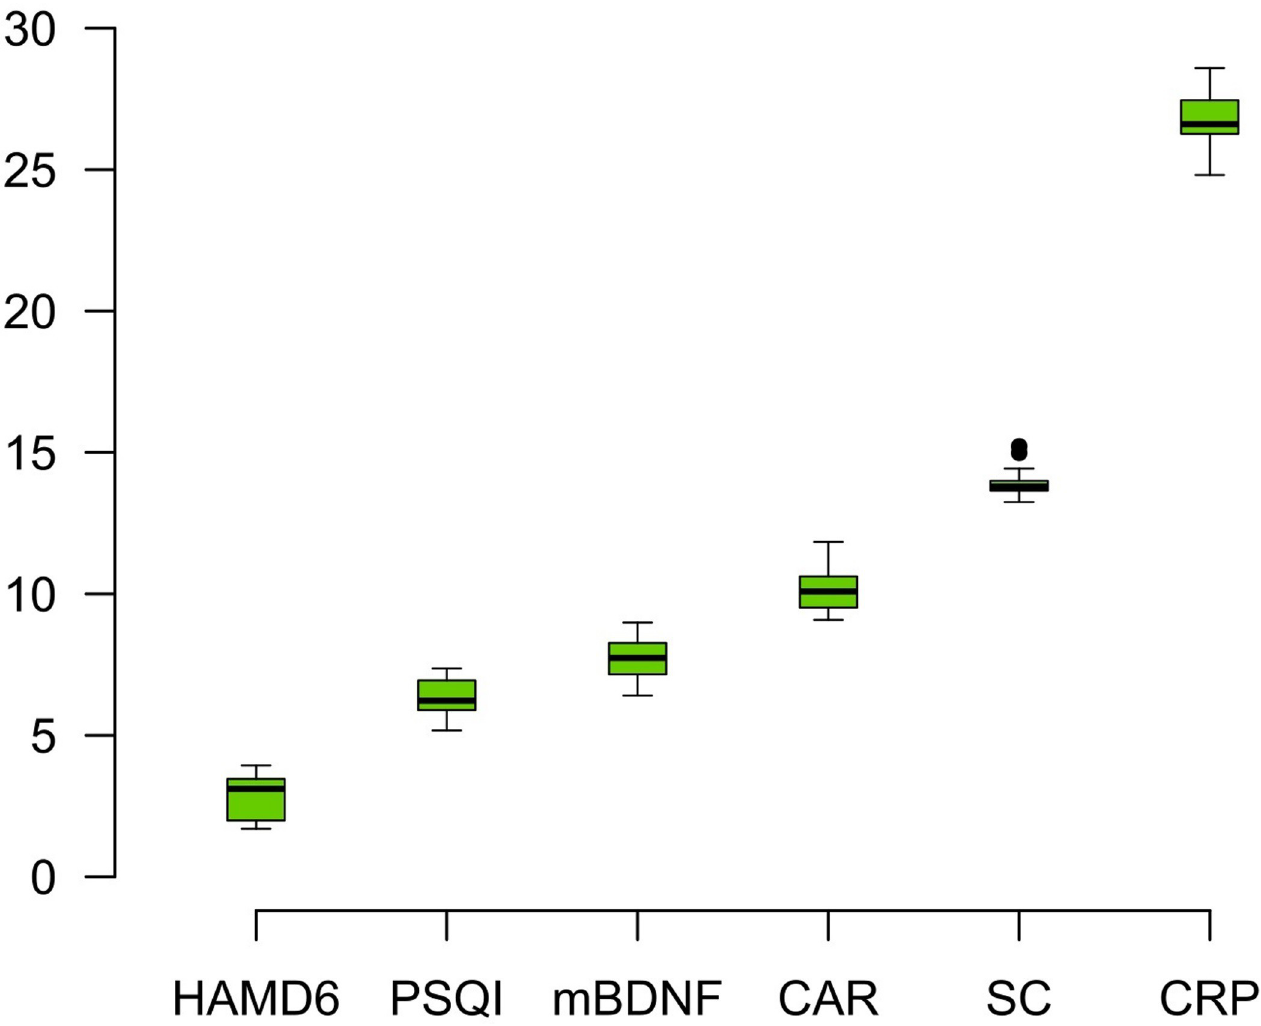
Fig 3. The random forest-based algorithm (Boruta) of parameter relevance for discrimination between patients in first depressive episode (MD n = 30) and patients with treatment-resistant depression (TRD n = 28). Colors: green = relevant (p < 0.05); yellow = tentative of relevance; red = no relevant.